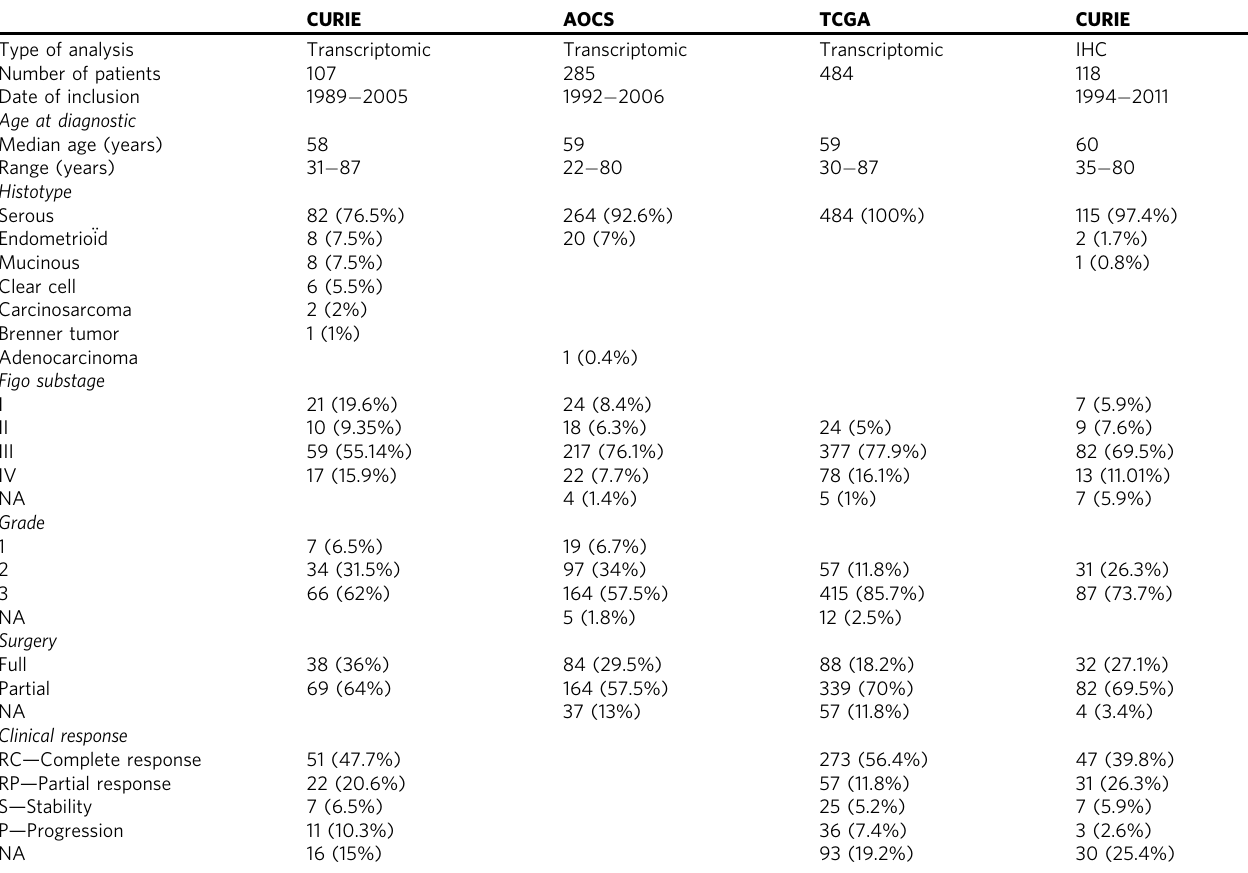
Table 1 Comparative description of the clinical parameters of the Institut Curie, AOCS and TCGA cohorts of HGSOC